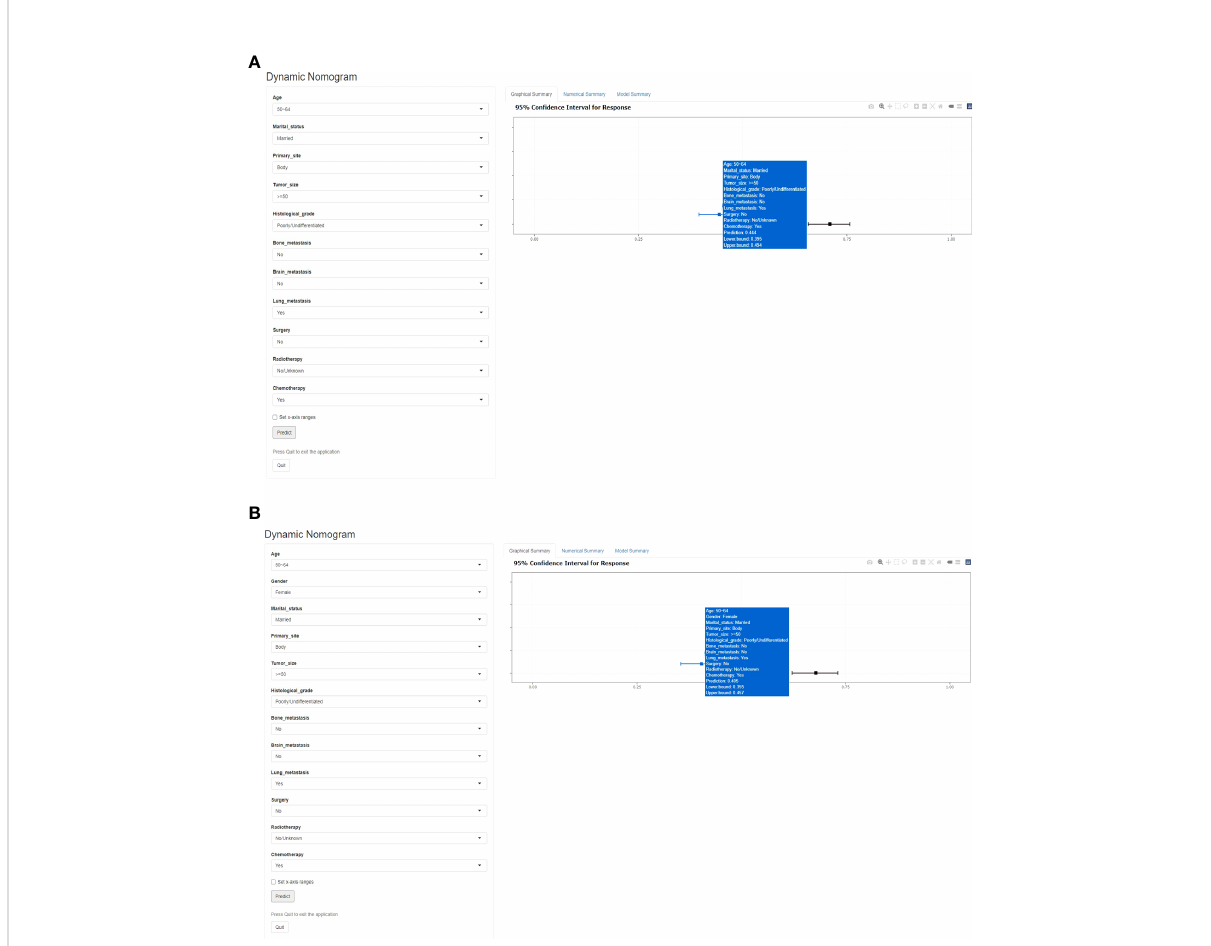
FIGURE 7 A web-based probability calculator. The graphical summary showed a rough range of (A) all-cause and (B) cancer-speci fi c early death probability and its 95% con fi dence